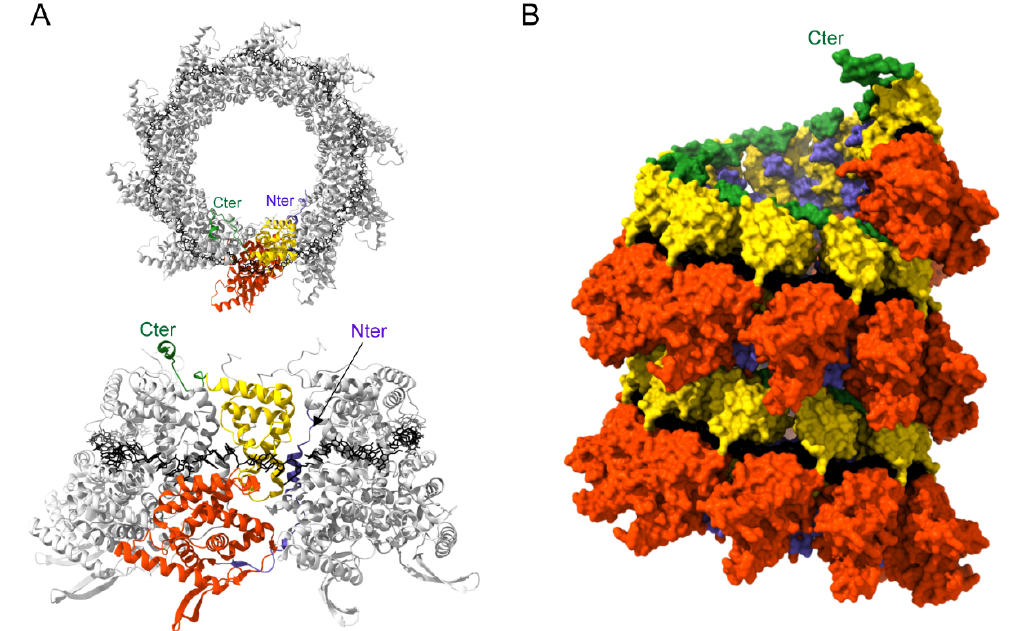
Figure 5. Structure of Pneumovirus N proteins. ( A ) Top (upper panel) and side (lower panel) views of hRSV N-RNA rings composed of 10 N proteins bound to RNA, purified from E. coli (PDB: 2WJ8 and 5FVC, respectively). N monomers are represented in ribbons; one N subunit is colored with the N NTD in orange, N CTD in yellow, and the N- and C-terminal parts in blue and green, respectively. The RNA is represented with the bases in black. N- and C-terminal extremities are indicated. ( B ) Left-handed N-RNA helix model (PDB: 4BKK). N monomers and RNA (black) atoms are shown as surfaces. One N subunit is colored with the N NTD in orange, N CTD in yellow, and the N- and C-terminal parts in blue and green, respectively. The C-terminal extremity of the N monomer at the top of the helix model is annotated. Created with UCSF ChimeraX [100].